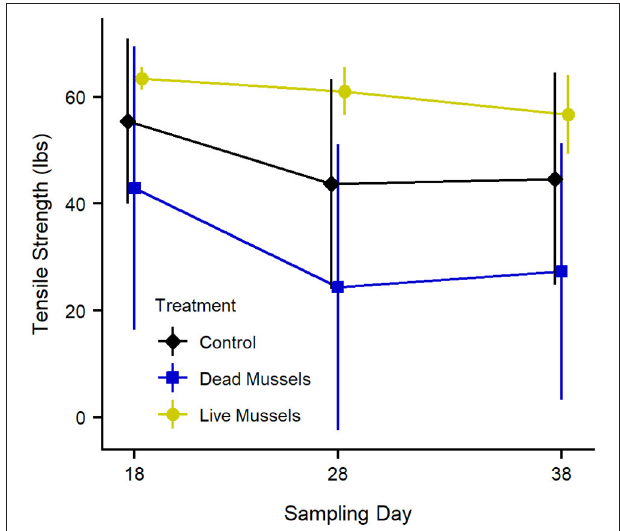
FIGURE 4 | Tensile strength (lbs.) as a proxy for decomposition of organic matter within different treatments. Cotton strips have a starting mean tensile strength of 65.61 lbs ( SD = 1.97 lbs). Points represent the mean, while the lines indicate the standard deviation. Decomposition was higher in the mortality treatments than the live treatments and is statistically significant based on Type III ANOVA, Tukey HSD, p <